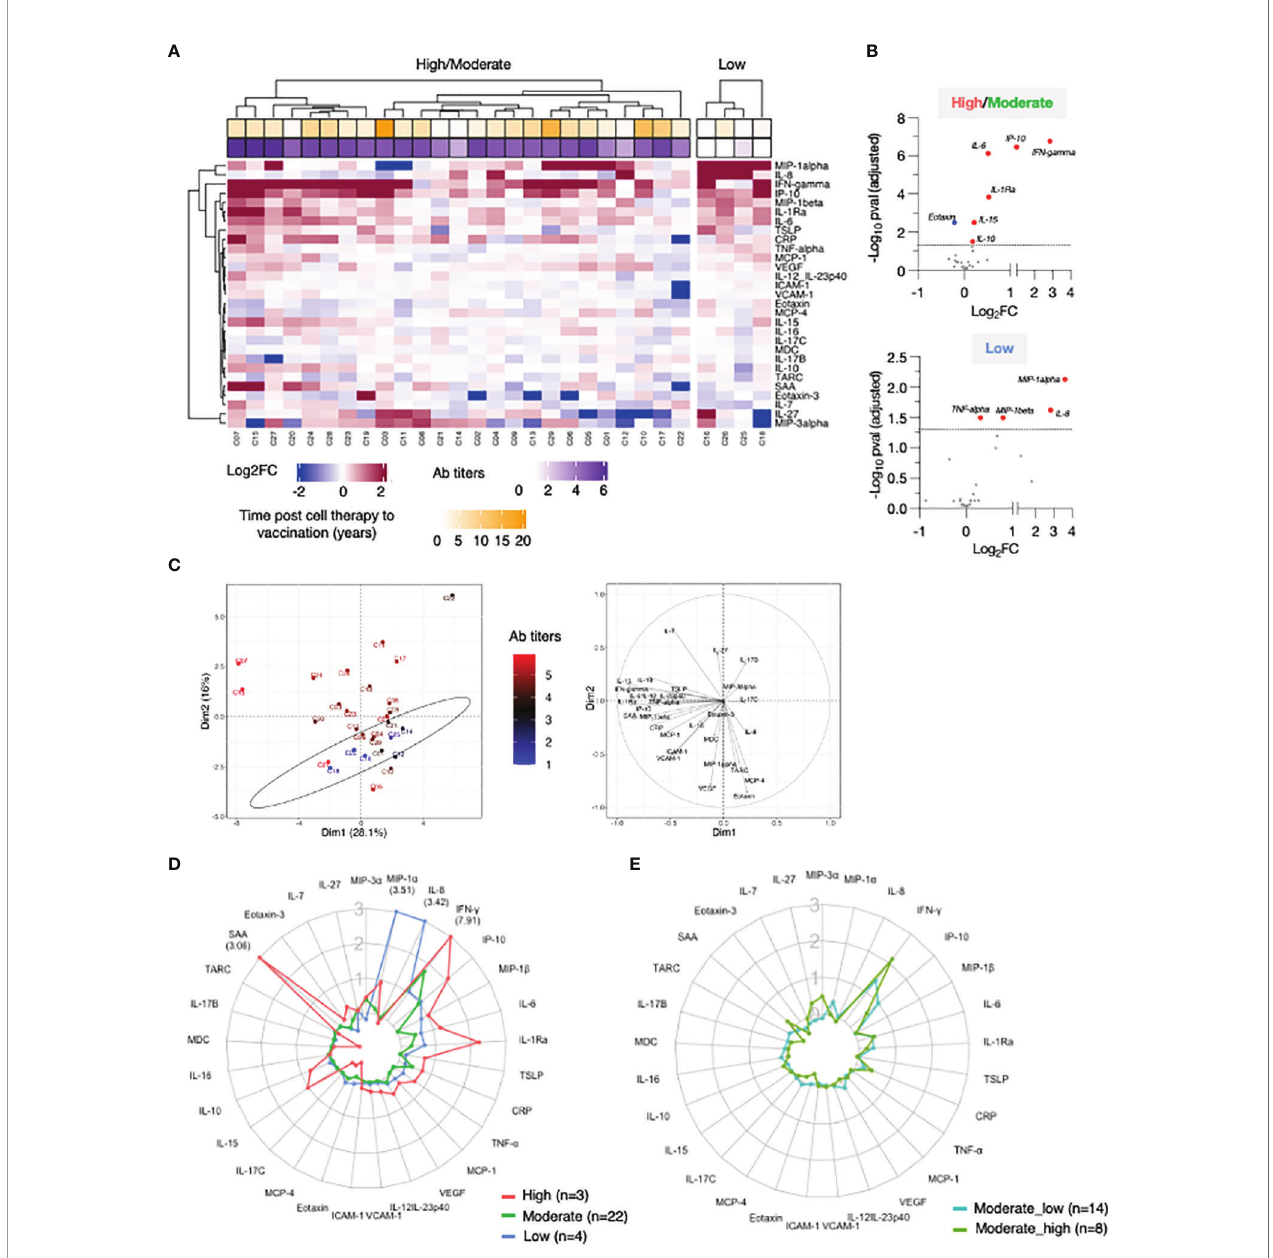
FIGURE 2 | Cytokine pro fi le in patients after 2 nd vaccination. Serum levels were measured before (d22) and 24 hours (d23) after 2 nd vaccination using the MSD platform for patients. (A) Heatmap depicted log2FC (d23_d22) in 29 analytes. Heatmap is annotated with anti-Spike Ab titers measured at d50 and years since cell therapy (transplantation and CAR-T). Patients were separated int two groups based on their ability to mount anti-Spike Ab responses to the vaccination: high/moderate responders (left heatmap) and non-responders (right heatmap). Patients are clustered based on their overall cytokine/chemokine pro fi le. (B) Volcano plot of data shown in Panel A depicts differentially expressed cytokines upon 2 nd vaccination at d23 in comparison to d22. Vaccine-induced effects are shown for high responders (left panel) and non-responders (right panel). Red dots indicate signi fi cant upregulation; blue dots indicate signi fi cant downregulation (adjusted p value<0.05 represented by the broken horizontal line). (C) PCA plot (left panel) distinguishes patients based on their systemic cytokine responses to the 2 nd vaccination, capturing 28.1% and 16% of the dataset variance along PC1 and PC2, respectively. Patients are annotated with their anti-Spike Ab titers measured at d50, with the highest value in red and lowest in blue. PCA loading plot (right panel) showed how strongly cytokines (depicted as grey vectors) in fl uence both PC1 and PC2. The projection of the vectors on PC1 and PC2 corresponds to the loading value (weight) of the cytokine they represent. (D) Patients were separated into 3 groups based on anti-Spike antibody titers measured at d50 (low in blue, n = 4; moderate in green, n = 22, green; high in red, n = 3, red). Radar plot compared the median log2FC for each cytokine after 2 nd vaccination (d23_22) among the 3 groups. Plot axis is truncated at log2FC=3, with values exceeding this cutoff shown in parentheses (high responders: IFN- g =7.91; SAA=3.06). (E) Patients in the moderate group were further separated into moderate_high (n=8) and moderate_low (n = 14). Radar plot compared the median log2FC for each cytokine after 2 nd vaccination (d23_22) between the 2